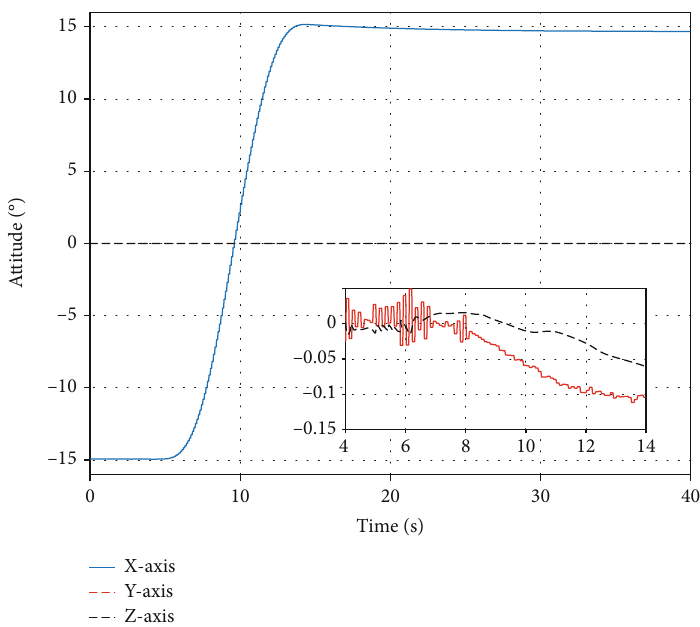
Figure 9: Attitude angle of payload module with compound controller.